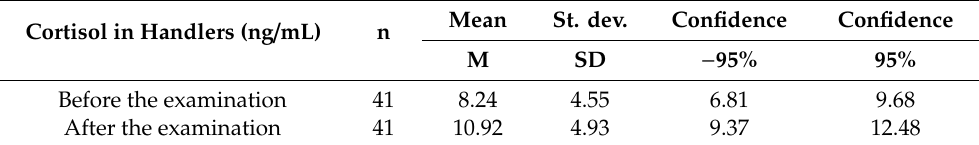
Table 1. Basic descriptive statistics for salivary cortisol levels in the handlers before and after the examination. Mean St. dev. Confidence Cortisol in Handlers (ng / mL) n Before the